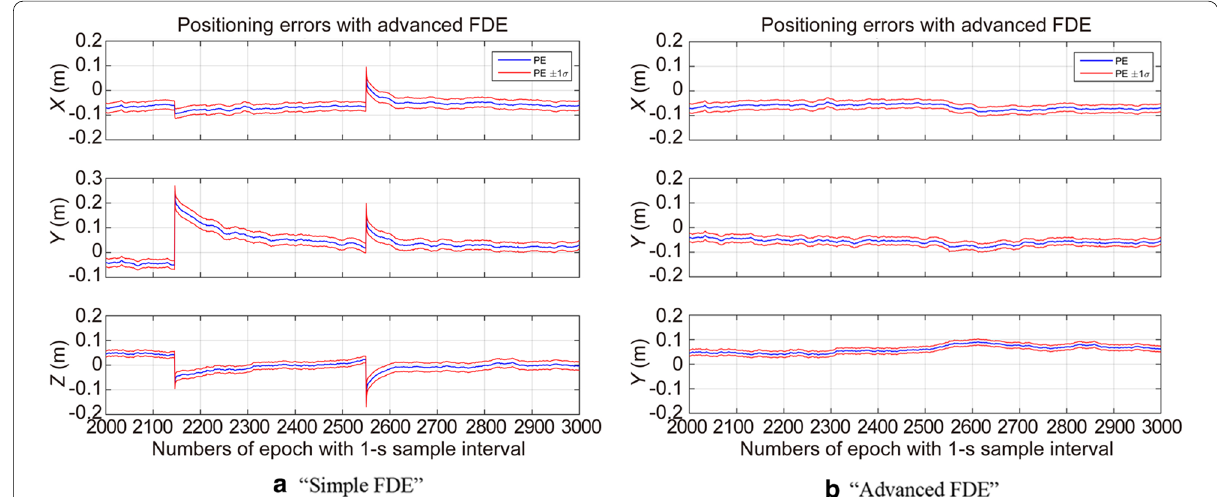
Fig. 4 PPP positioning errors (after convergence) with the “Simple FDE” and “Advanced FDE” in PPP‑Wizard. Note the impact of undetected faults and wrong exclusions can be seen in a